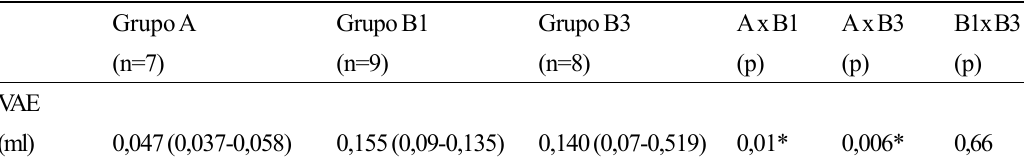
Tabela 2. Análise das medidas ecocardiográficas do VAE no plano ortogonal no grupo controle (A) e nos